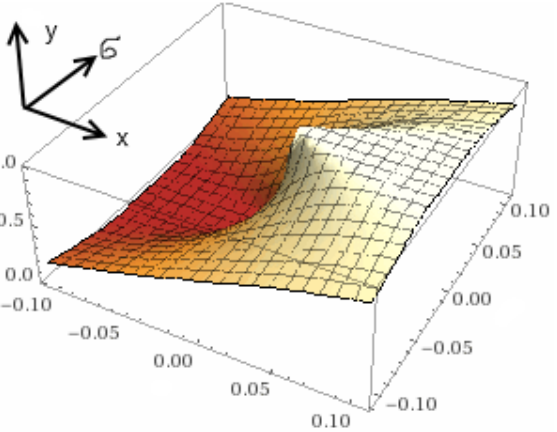
Figure 6. 3D representation of the Gaussian distribution density of a normalized random variable y = θ ( u ), where x = u = ( ω − ξ )/( ξ · σ ), with the center ξ and variance σ 2.